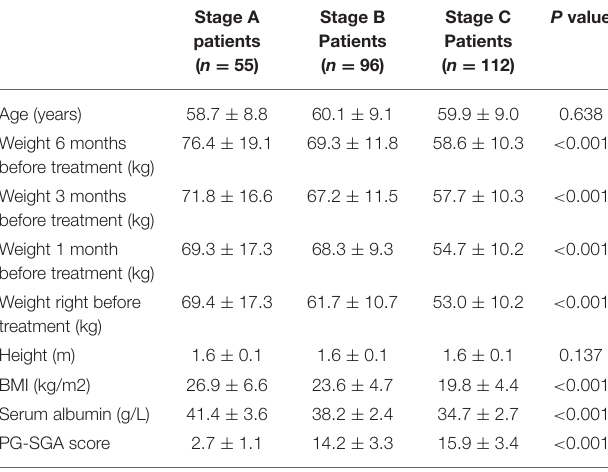
TABLE 1 | Characteristics of patients with different nutrition